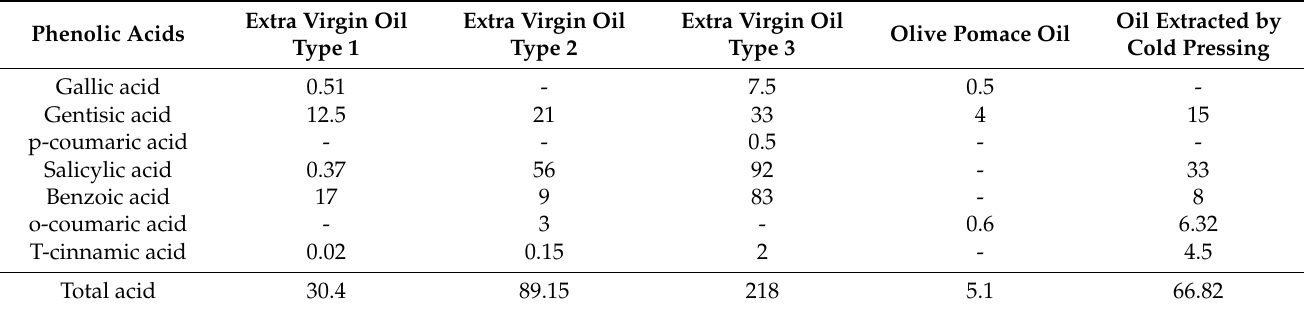
Table 3. Phenolic compounds detected (mg/L) in different olive oil samples.